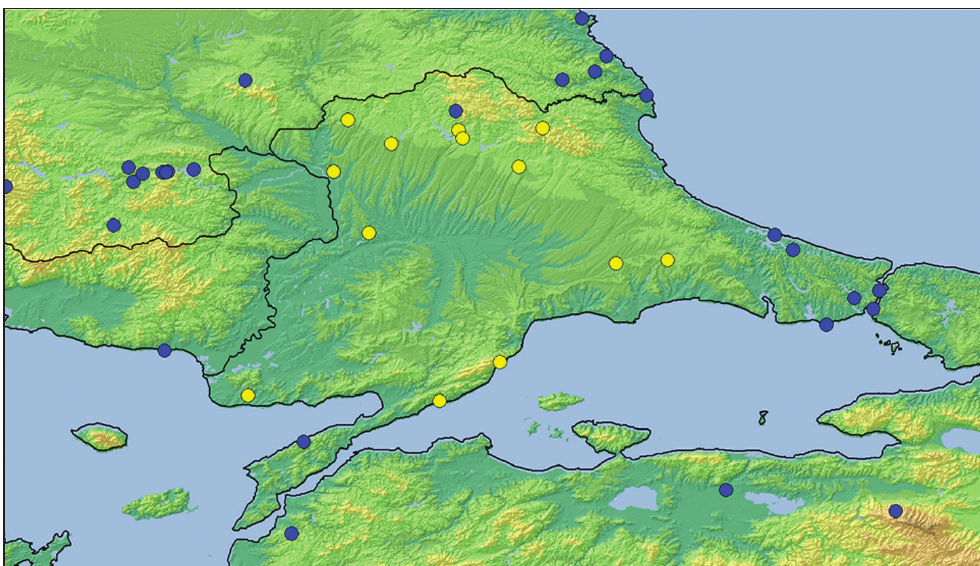
Figure 3. Distribution map of Adscita statices drenowskii in the Thrace Region with new data (yellow dots).